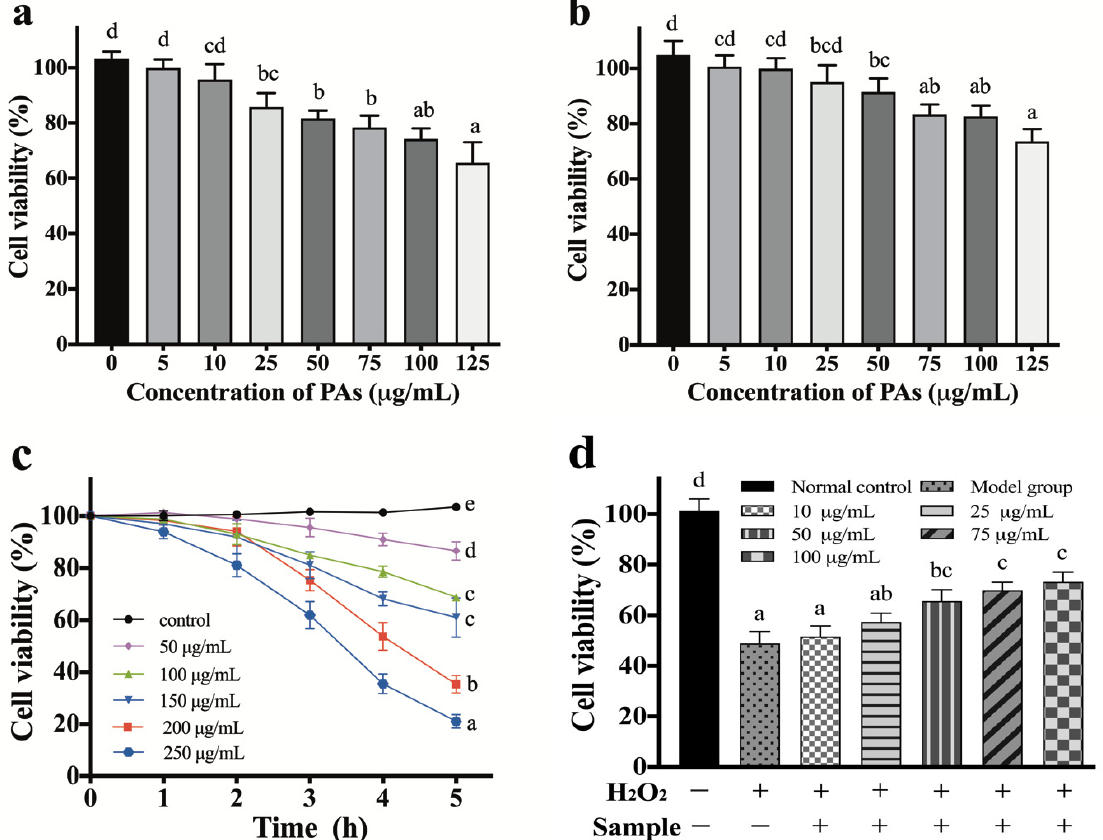
Figure 7. Cytotoxicity analysis of PKLPs by using various cells. ( a ) Caco-2 cells; ( b ) HepG-2 cells; ( c ) cell viability effect by various concentration of H 2 O 2 (0–250 μ g/mL); and ( d ) antioxidant potential of PKLPs on the H 2 O 2 -induced Caco-2 cells model after 24 h of incubation. Mean ± SD with different alphabet superscripts within the same column and analytical parameter indicate that values differ significantly ( p < 0.05).